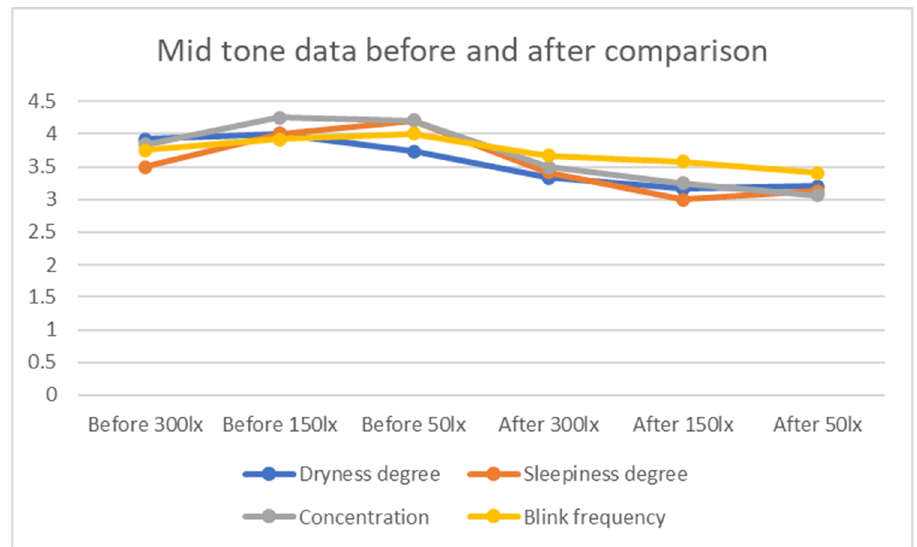
Figure 4. Line chart of visual fatigue rating before and after the experiment under three illumination levels in the warm tone paintings.